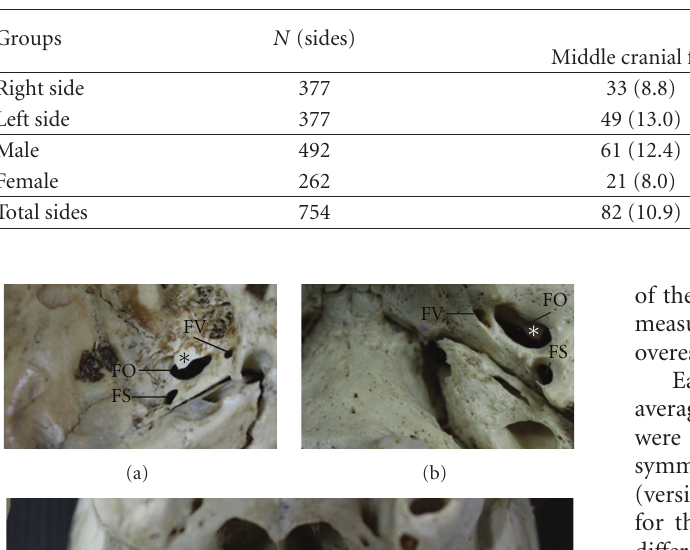
Table 1: Distribution of the FV found in analyzed dry skulls according to side and sex.